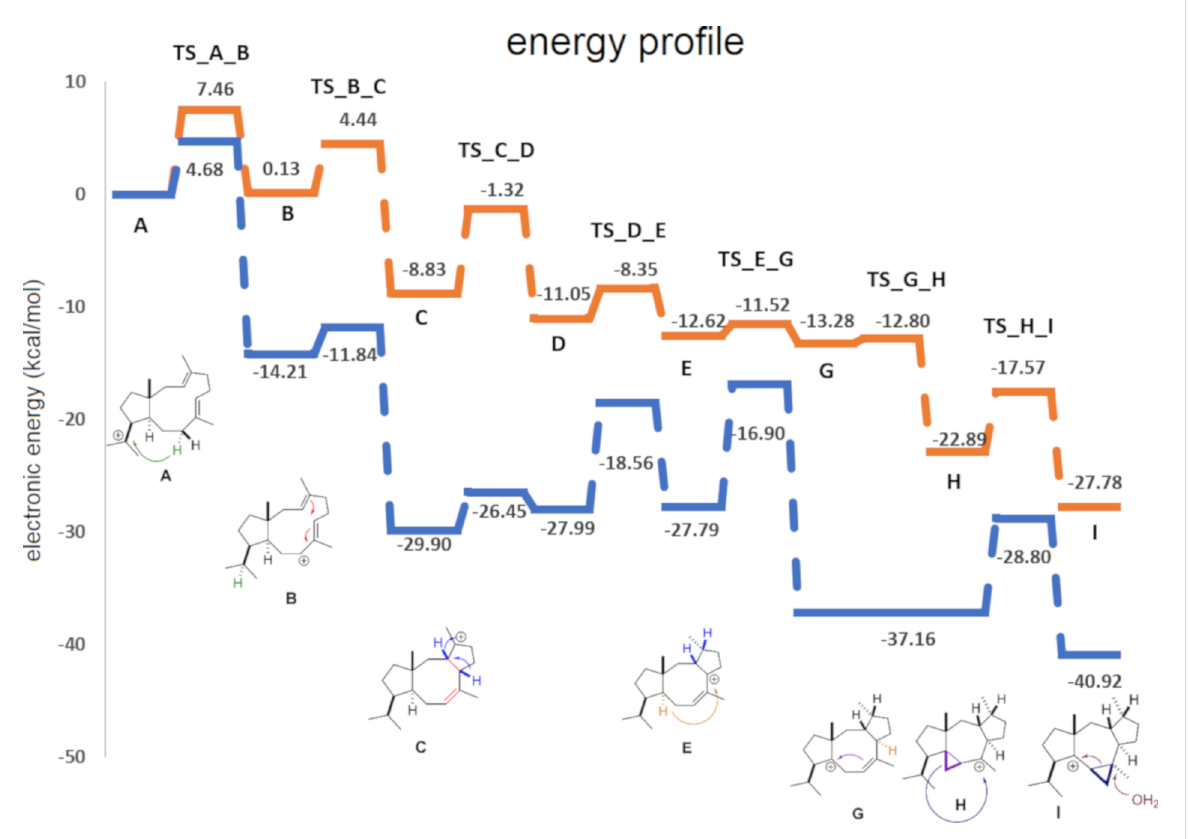
Figure 1: Computed electronic energy profiles (kcal/mol) for the CotB2 cyclase mechanism. The calculations used M062X/6-31+G(d,p).